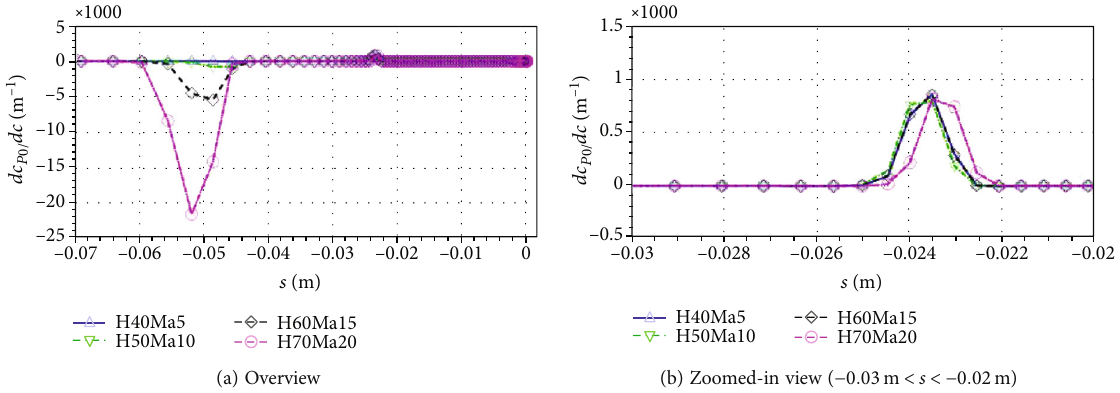
Figure 14: Analysis of the 1st order derivatives of the total pressure coe ffi cients along s